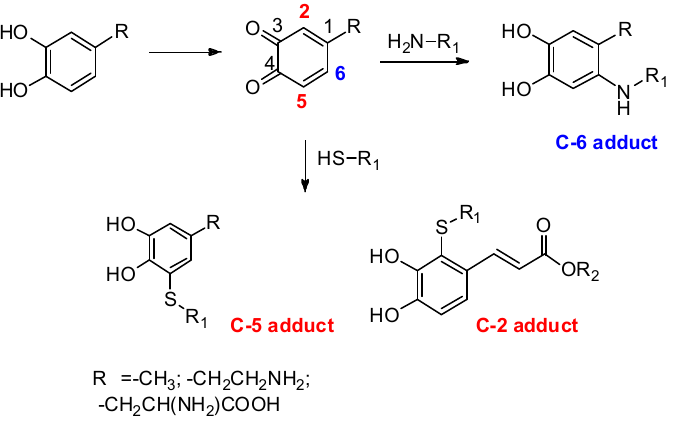
Scheme 7. Schematic overview of the regiochemistry of thiol/ ortho -quinone